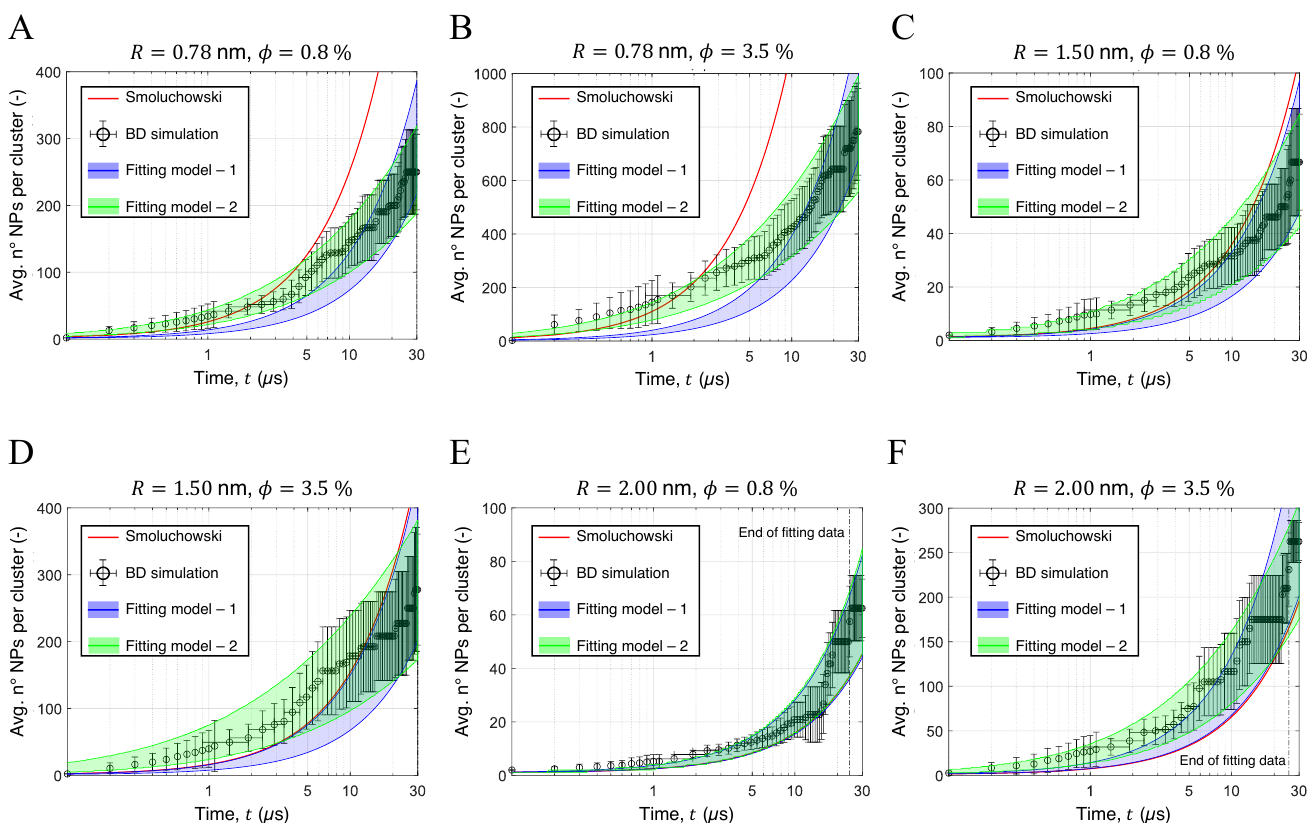
Figure 7. Comparison between the Smoluchowski theoretical model (solid red lines), the simulation data (black circles) and the modified aggregation models (shaded blue and green areas). The com- parison was performed considering the configurations with R = 0.78 nm and ( A ) φ = 0.8% or ( B ) φ = 3.5%; with R = 1.50 nm and ( C ) φ = 0.8% or ( D ) φ = 3.5%; with R = 2.00 nm and ( E ) φ = 0.8% or ( F ) φ = 3.5%. To avoid numerical artifacts in the fitting procedure, only the time frames presenting more than 5 clusters were considered by the fitting